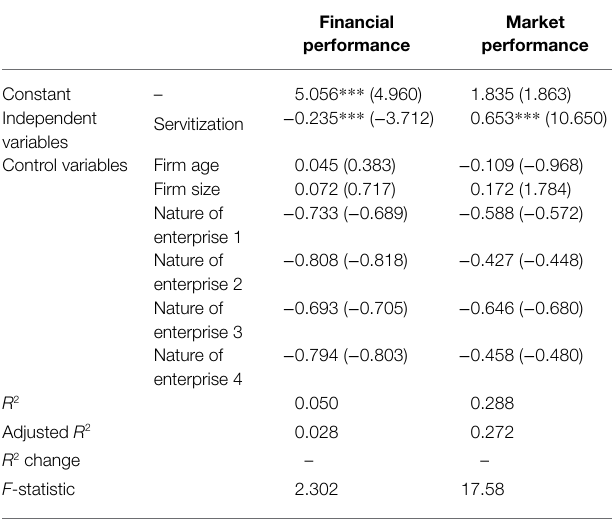
TABLE 8 | The effect of manufacturer’s servitization strategy on enterprise performance.